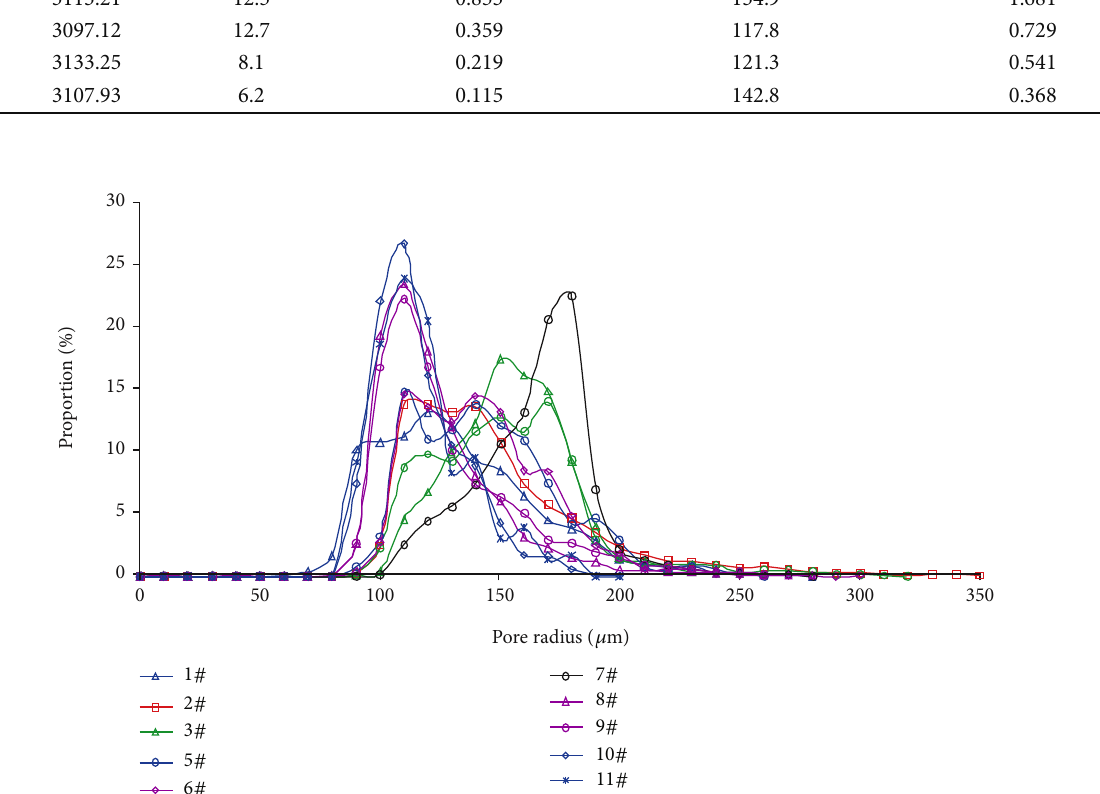
Figure 4: Probability curves of pore radius from 11 samples of